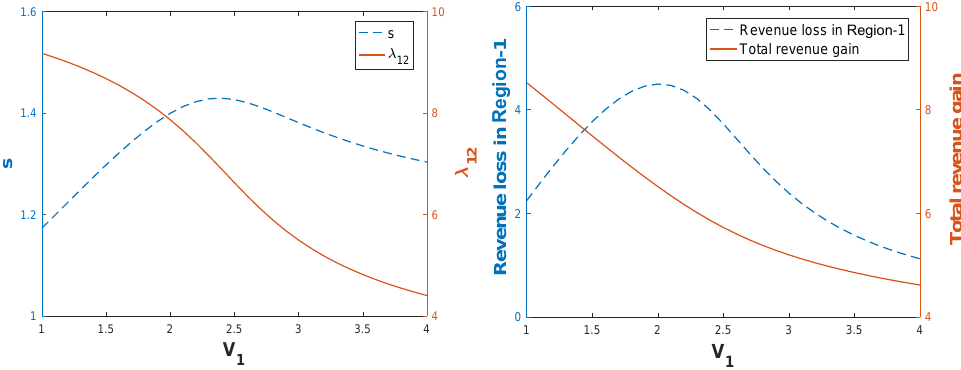
− π 0 . Revenue from commission: 1 1